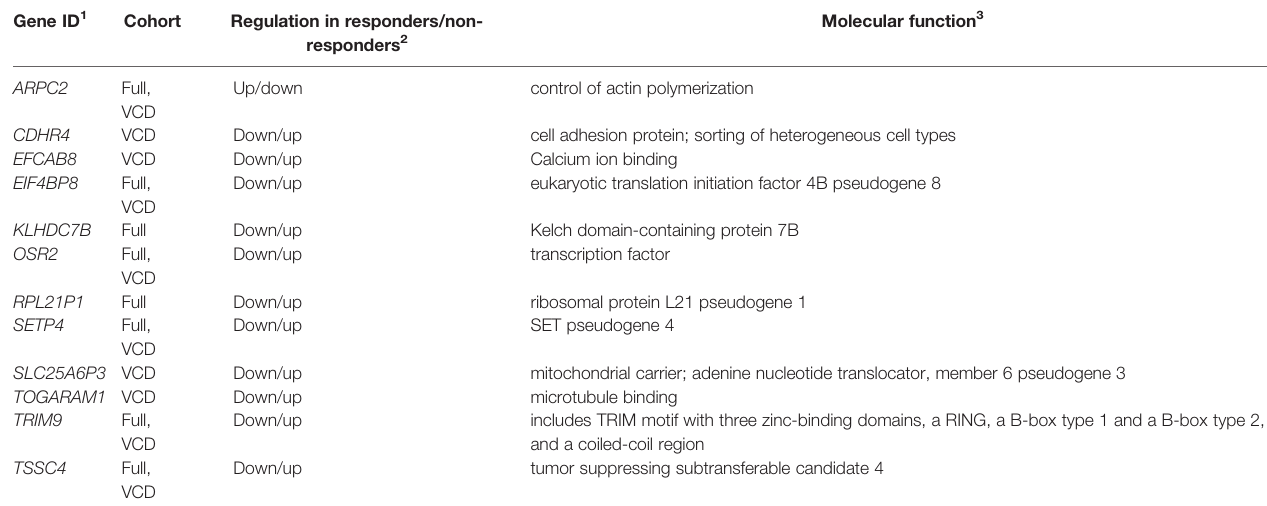
TABLE 2 | Core marker genes for the current PAD/VCD MM dataset (full cohort/VCD